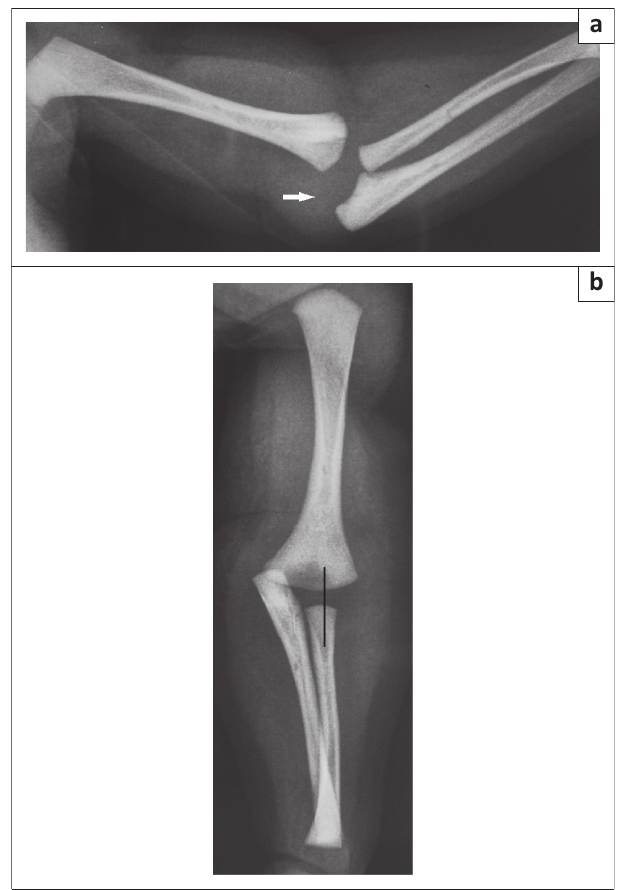
FIGURE 15: (a) Lateral projection in neonate with a swollen elbow shows marked soft tissue swelling. Ulna and radius appear posteromedially displaced (arrow). (b) AP projection with line drawn along radial shaft that intersects with expected position of the capitellum excluding dislocation and implying a transcondylar